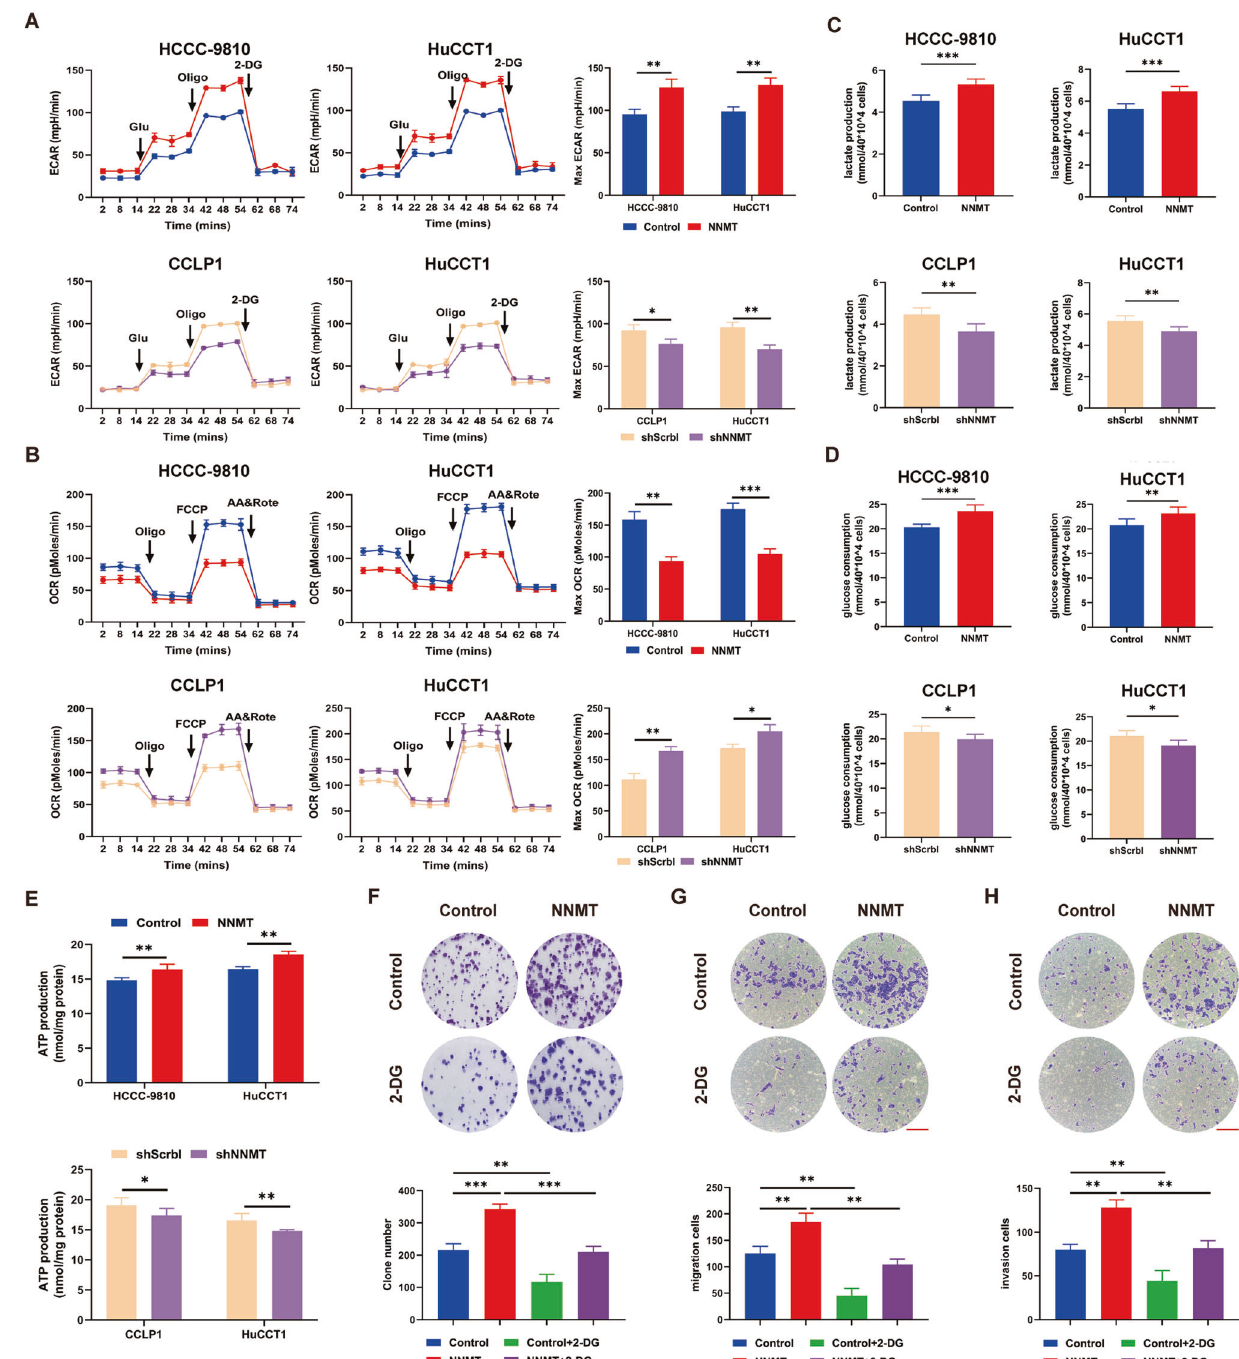
Fig. 4 NNMT promotes the progression of iCCA by regulating the Warburg effect. A The Seahorse X96 analyzer detects the ability of iCCA cell lines to excrete acid. B Seahorse X96 detects the oxygen consumption capacity of iCCA cell lines. Glu, glucose; Oligo, oligomycin; 2-DG, 2- deoxyglucose; FCCP, carbonyl cyanide 4-[tri fl uoromethoxy] phenylhydrazone; AA&Rote, antimycin A and rotenone. C The amount of lactic acid produced in iCCA cell lines. D Glucose consumption was measured in iCCA cell lines. E The amount of ATP produced in iCCA cell lines. F The colony formation experiment detected cell growth after the addition of 4 μ M 2-DG to the culture medium. G The Transwell experiment detected cell migration after the addition of 4 μ M 2-DG to the culture medium. H The Transwell experiment detected cell invasion after the addition to 4 μ M 2-DG to the culture medium. Scale bars: 100 μ m (data are mean ± SEM, * P < 0.05, ** P < 0.01, *** P < 0.001, n = participate in the aerobic glycolysis in iCCA cells to promote NNMT promotes the Warburg effect in iCCA proliferation and metastasis. We con fi rmed our hypothesis by Many studies have con fi rmed that aerobic glycolysis plays an comparing the key cell metabolism and bioenergy parameters of important role in tumor cells. NNMT has been con fi rmed to be iCCA cell lines with NNMT overexpression or knockdown and involved in methyl metabolism, lipid metabolism and glucose control cell lines. NNMT overexpression signi fi cantly decreased metabolism in cells. Therefore, we speculated that NNMT may